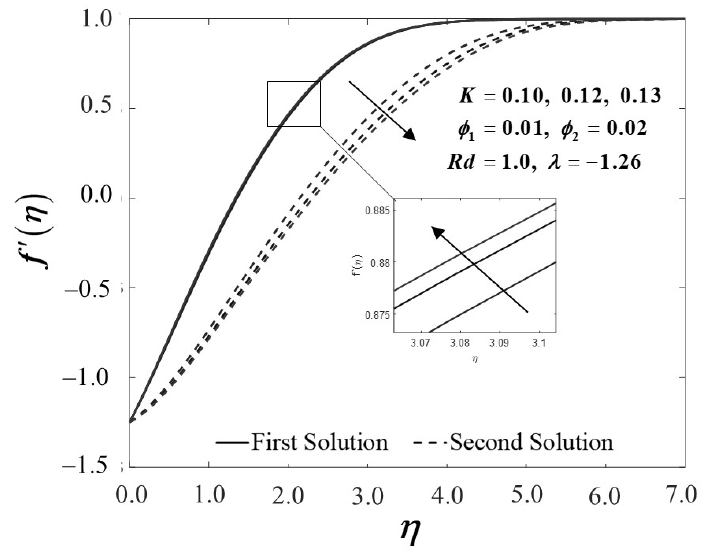
( ) f η′ towards η by assorted K . Figure 6. ( ) Figure 6. f (cid:48) ( η ) towards η by assorted K . f η′ towards η by assorted K . Figure 6.